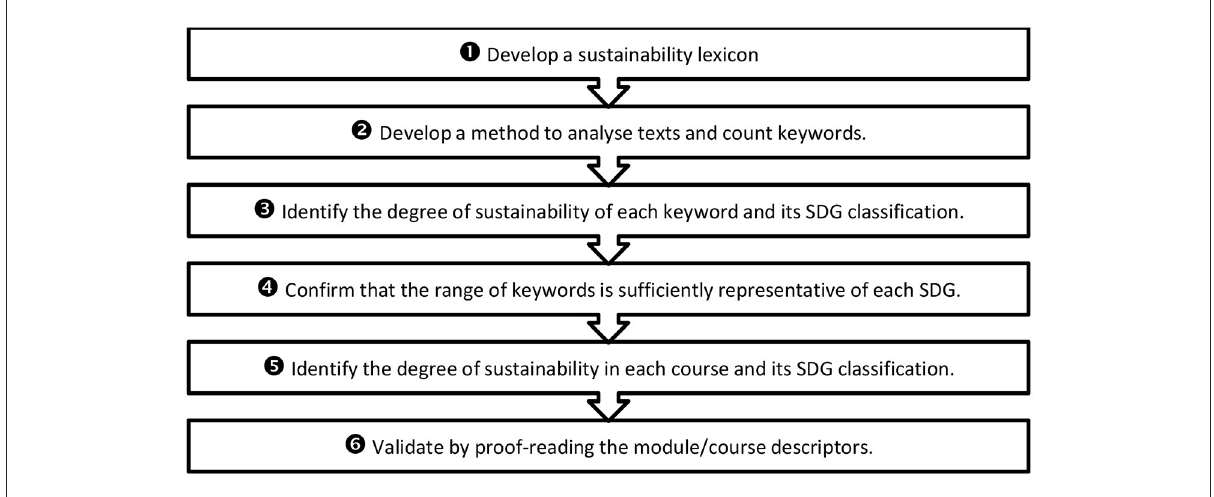
FIGURE3 Process for analyzing sustainability in module/course descriptors at TU Dublin. Steps 1 to 5 are detailed in this